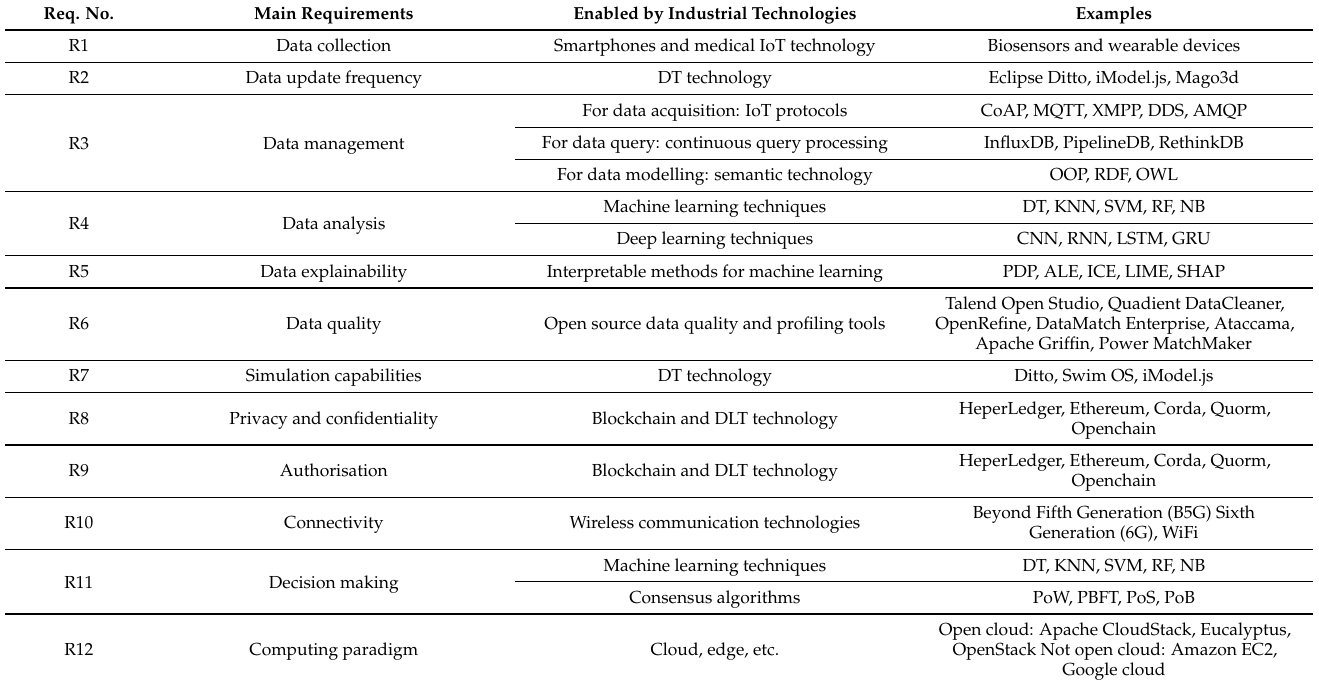
Table 7. Validation of fulfilment requirements from the technology perspective for the proposed